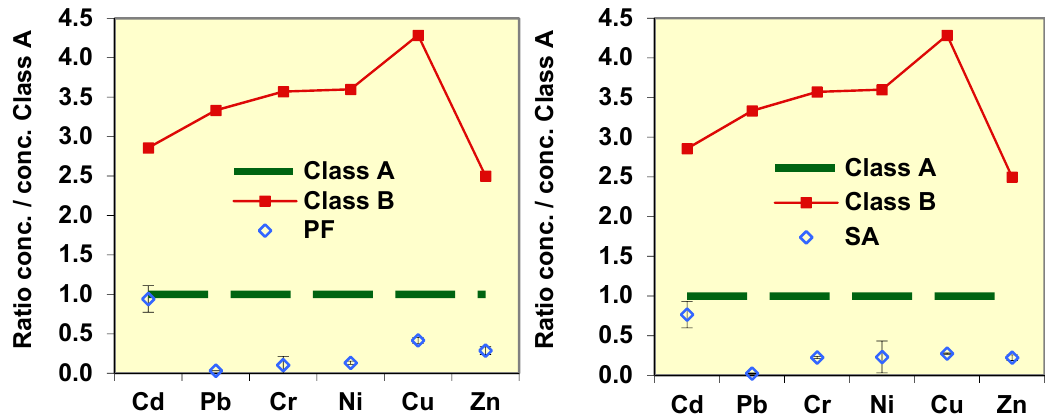
Figure 7. Mean concentration ( ± S.D.) of heavy metals in the final compost from PF and SA.